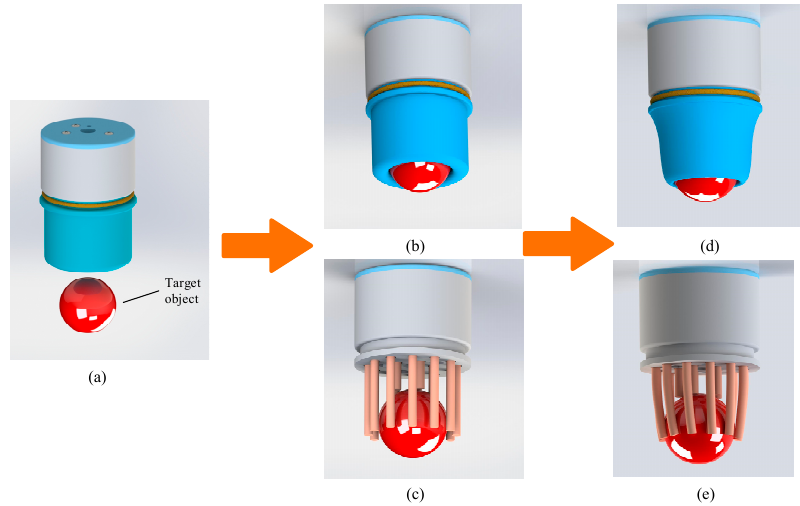
Figure 7. Grasping process of the robot hand: ( a ) before grasping, ( b ) self-adaptive step, ( c ) self-adaptive step hiding membrane, ( d ) gripping step, and ( e ) gripping step hiding membrane.